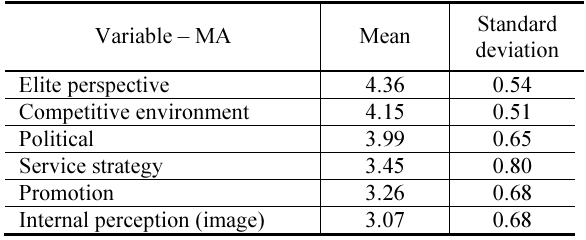
Table 6. Ranking of the attitudes toward marketing activities Variable – MA Mean